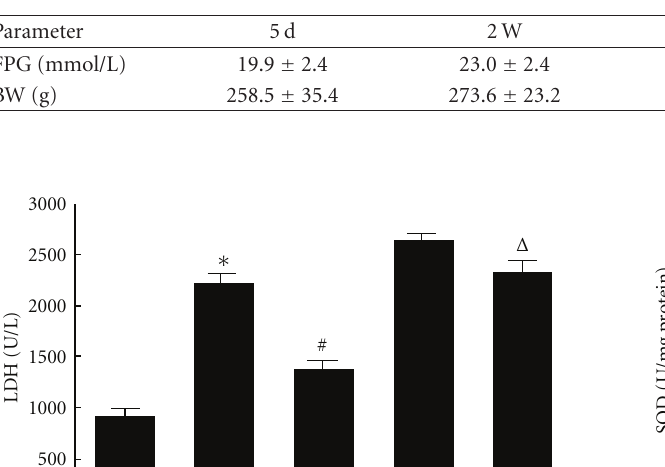
Table 1: The fasting plasma glucose and body weight of diabetic rats ( n = 60).